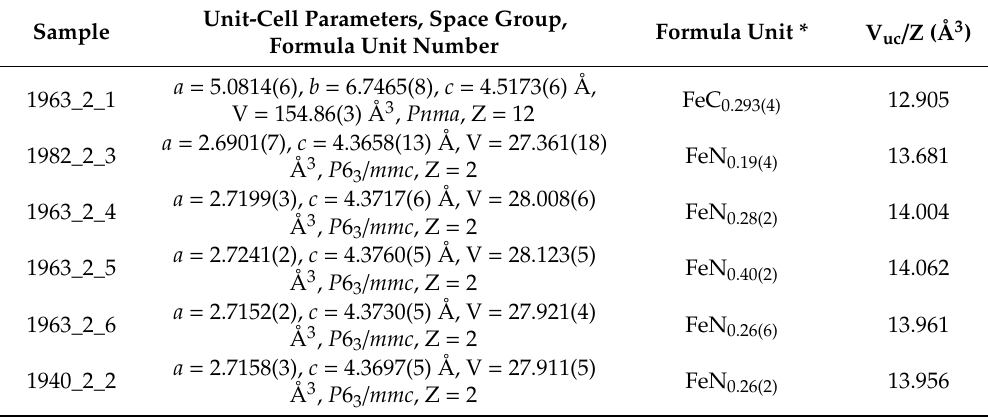
Table 3. Results of X-ray single-crystal analysis of Fe(C,N) n .